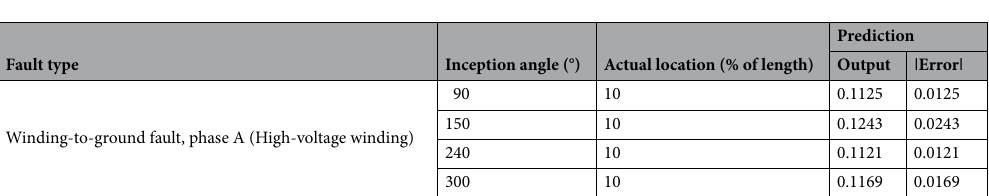
Table 5. Fault location for phase A winding-to-ground faults on high-voltage winding with various inception angles.